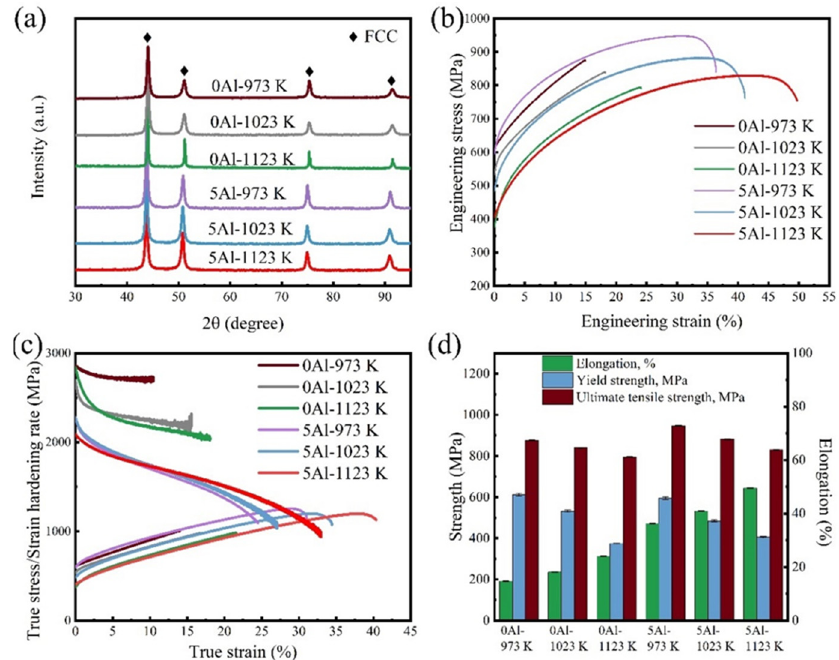
Figure 3. ( a ) XRD patterns; ( b ) engineering stress–engineering strain curves; ( c ) strain hardening rates and true stress–true strain curves; and ( d ) Comparison of the yield strengths, tensile strengths, and tensile elongations of the studied (Co 40 Fe 25 Cr 20 Ni 15 ) 100 − x Al x (x = 0 and 5 at.%) specimens.